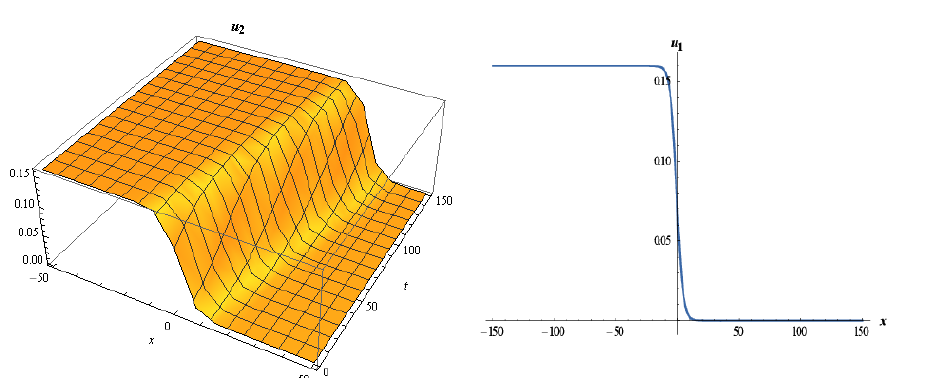
Figure 2. Three and two-dimensional surfaces of (19).